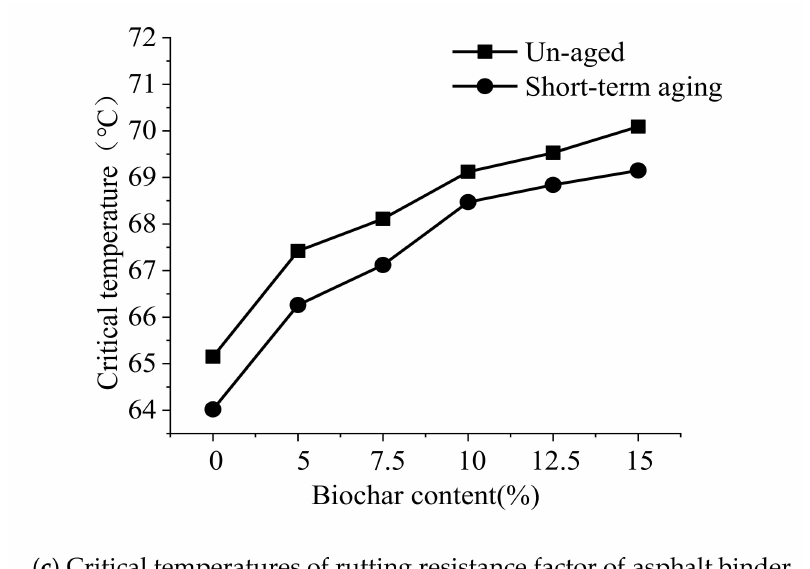
Figure 6. Rutting factors and critical temperatures of asphalt binders under di ff erent aging